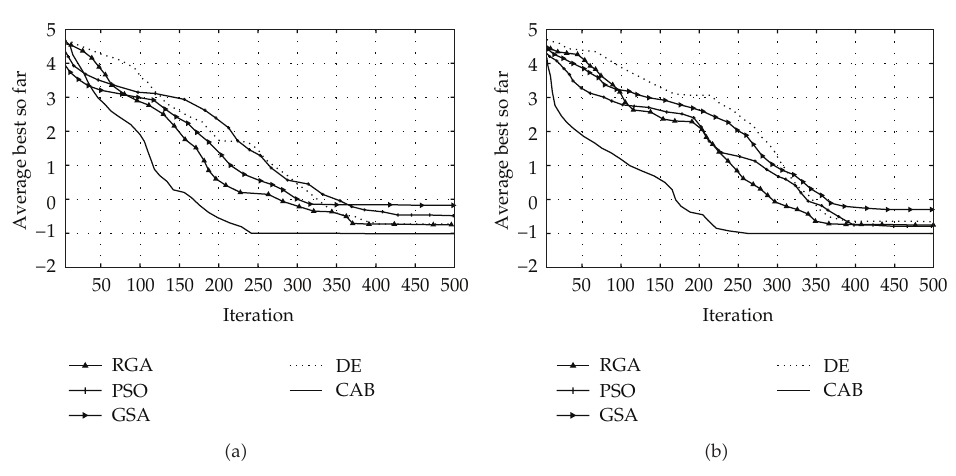
Figure 5: Performance comparison of RGA, PSO, GSA, DE and CAB for minimization of the GKLS- functions: (cid:2) a (cid:3) f and (cid:2) b (cid:3) f . 28 31 Table 8: Minimization result of GKLSfunctions in Table 16. Maximum number of iterations (cid:8) 500. RGA PSO